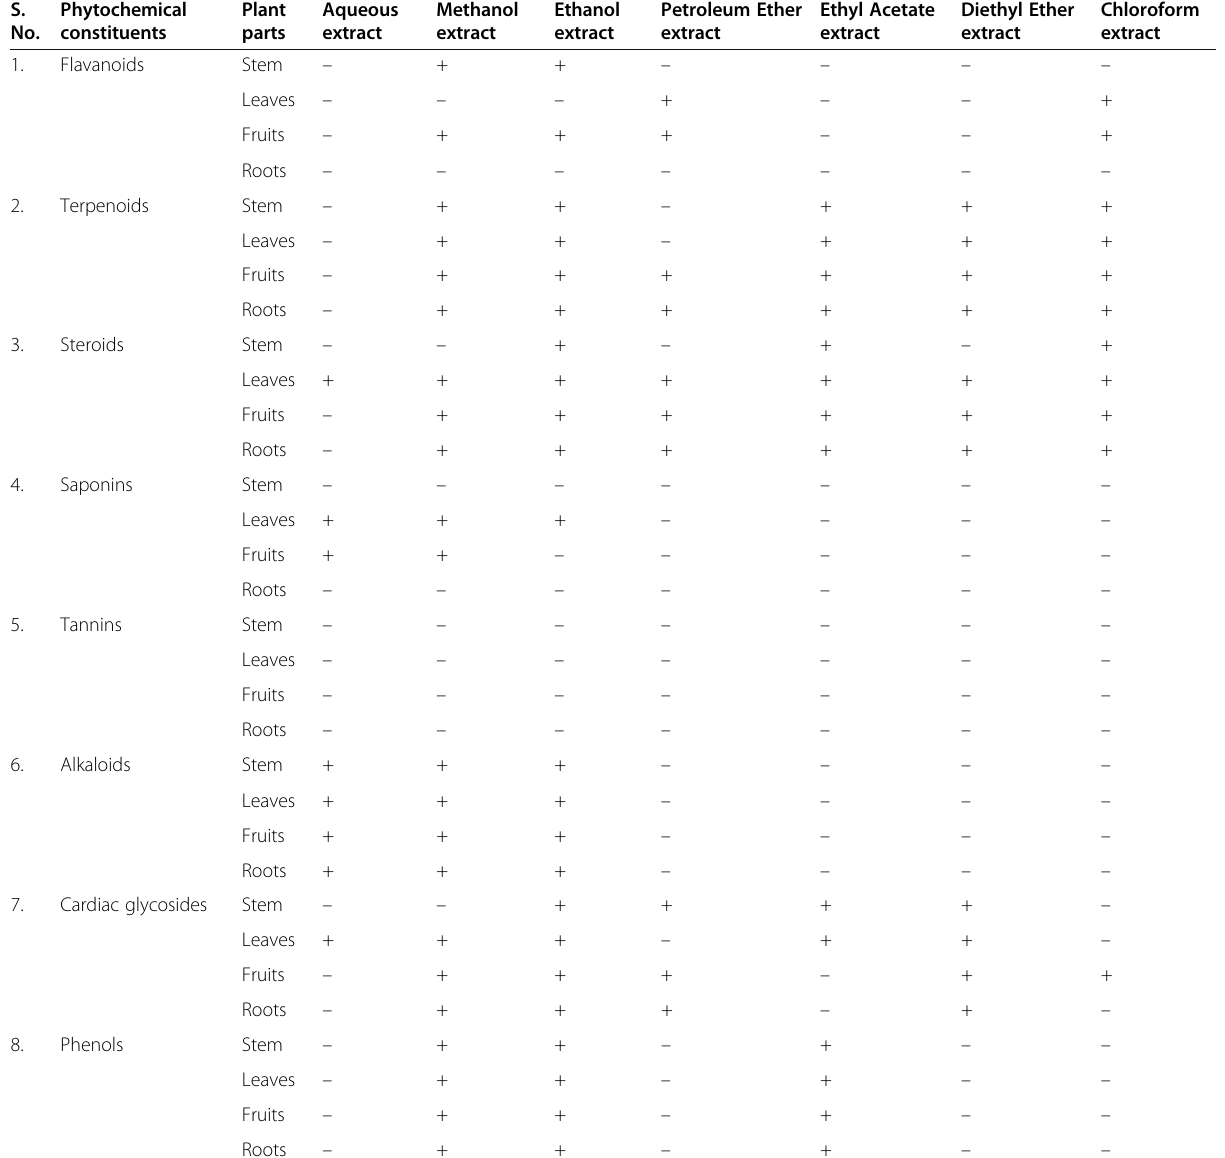
Table 1 Phytochemical screening of different parts of Solanum xanthocarpum Schrad. and